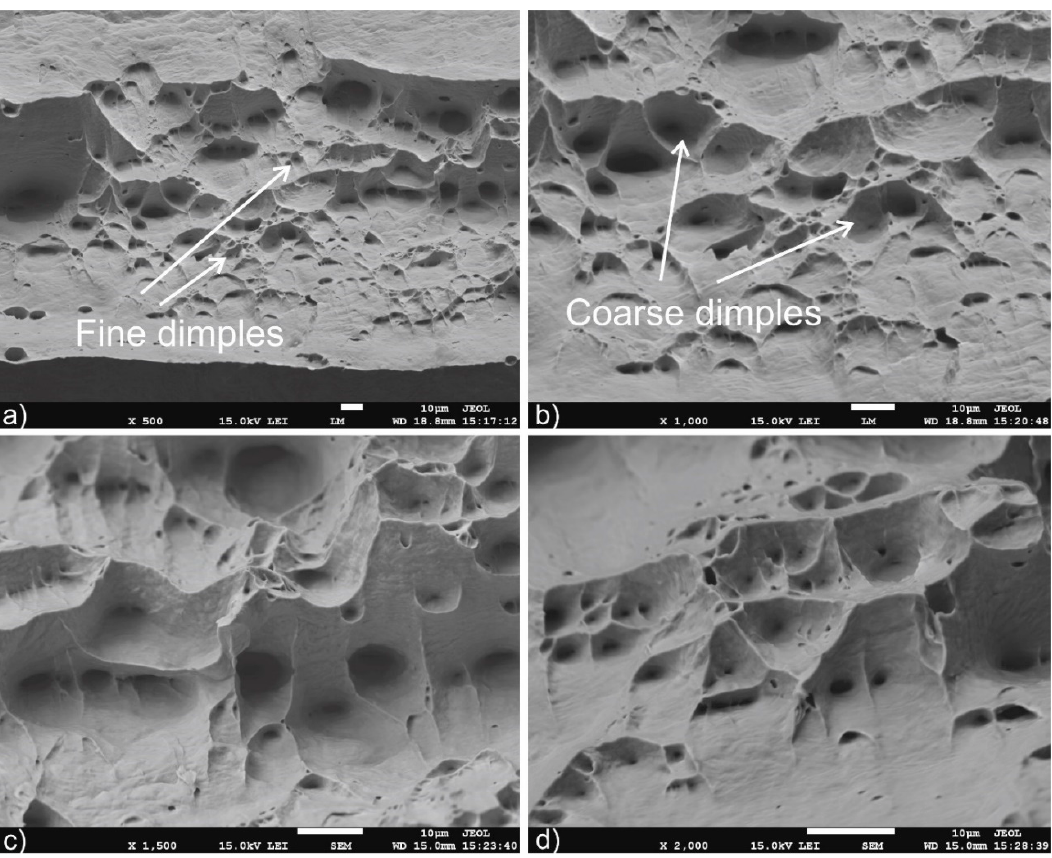
Figure 14. Fracture surfaces after tensile testing weld No. 5. ( a ) fine dimples zone of fracture surface, ( b ) coarse dimples, ( c ) and ( d ) higher magnification of zone observed in ( b ) .